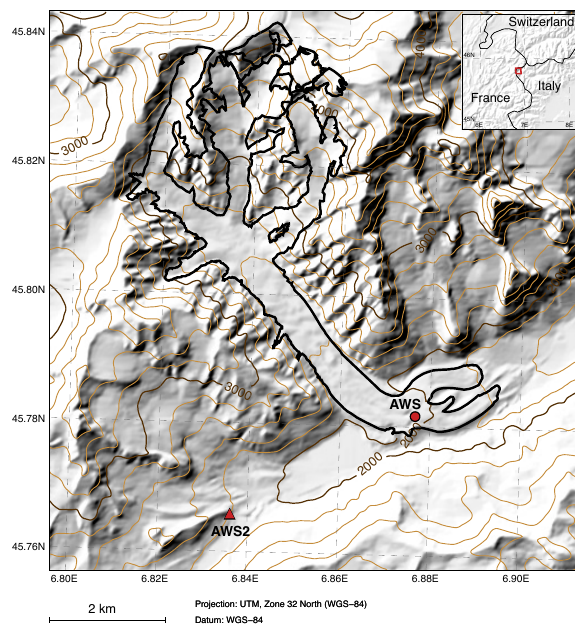
Figure 2. Map showing the location of the Miage Glacier. The AWS located on the glacier is denoted with a red circle and the AWS2 from which precipitation data were obtained is shown by a red tri- angle.